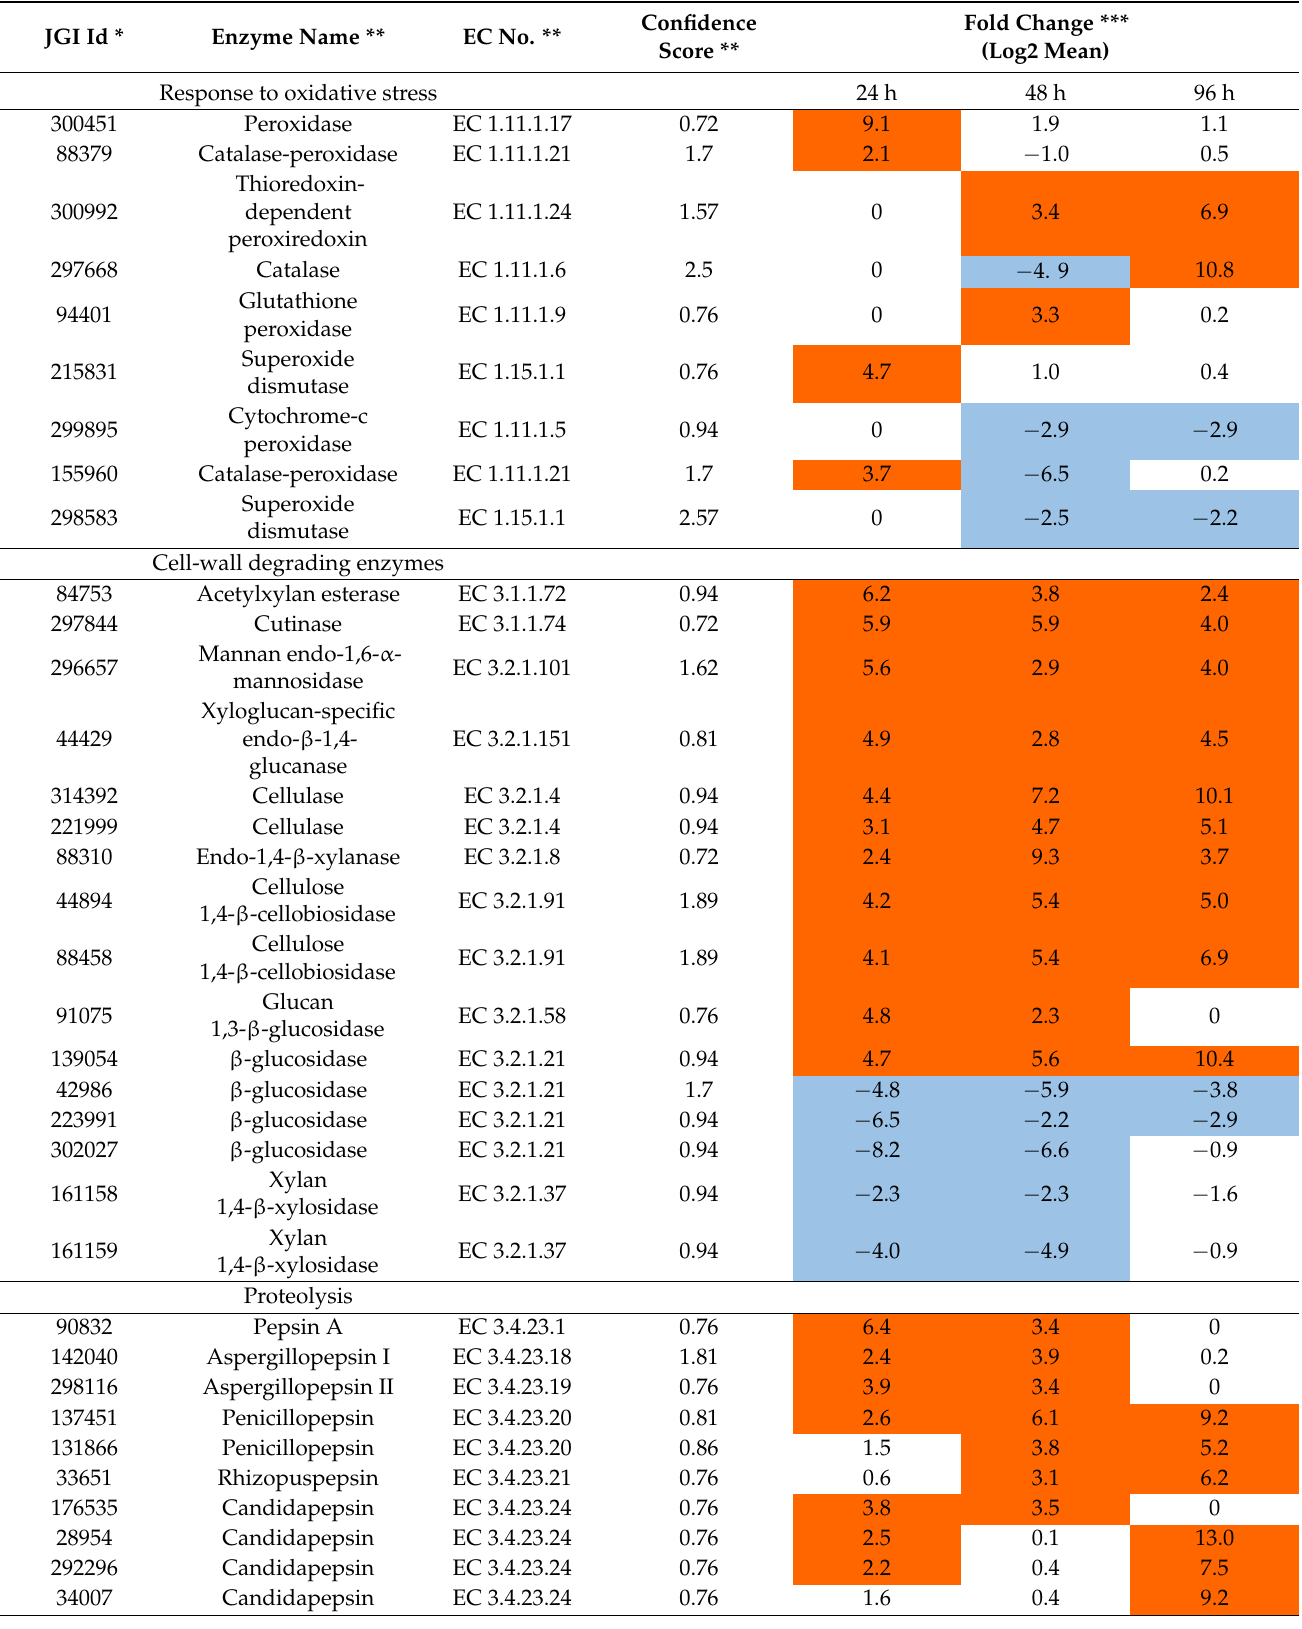
Table 1. Representative predicted enzymes differentially modulated in T. atroviride secretome at 24, 48, and 96 h of co-culture with Arabidopsis